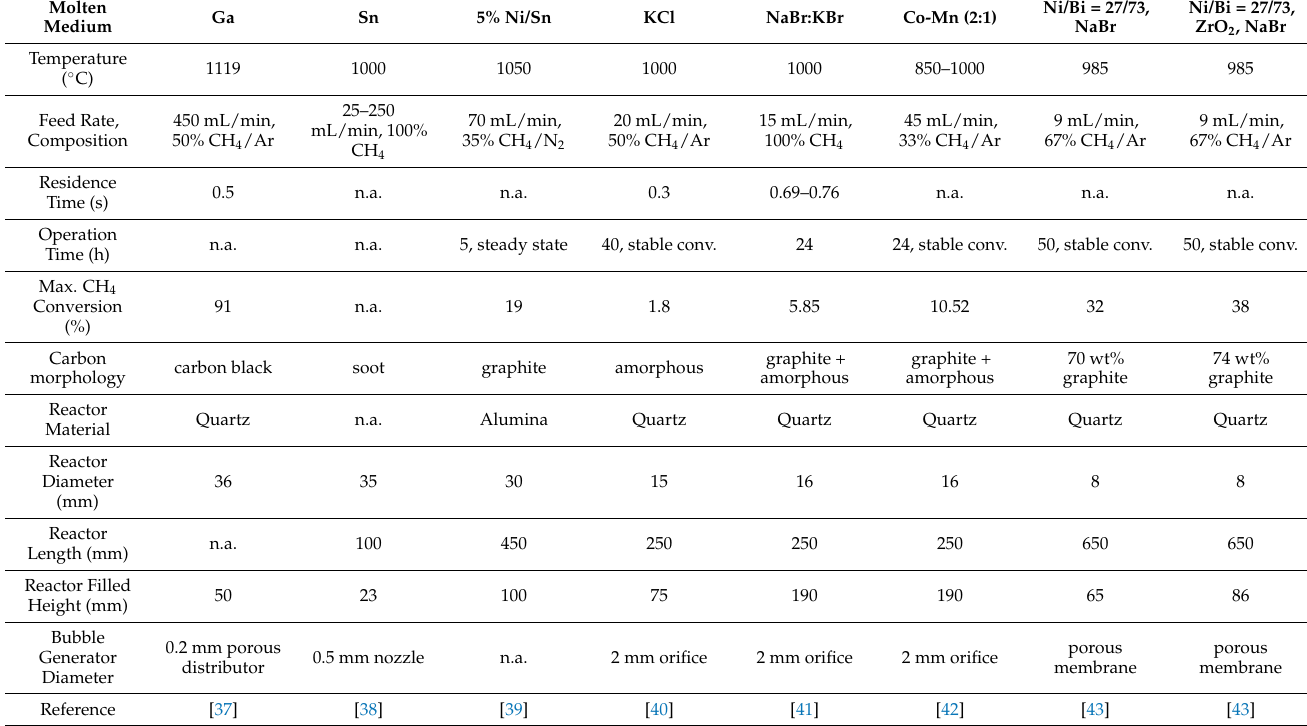
Table 2. Results of methane pyrolysis 2021–2022 publications in molten